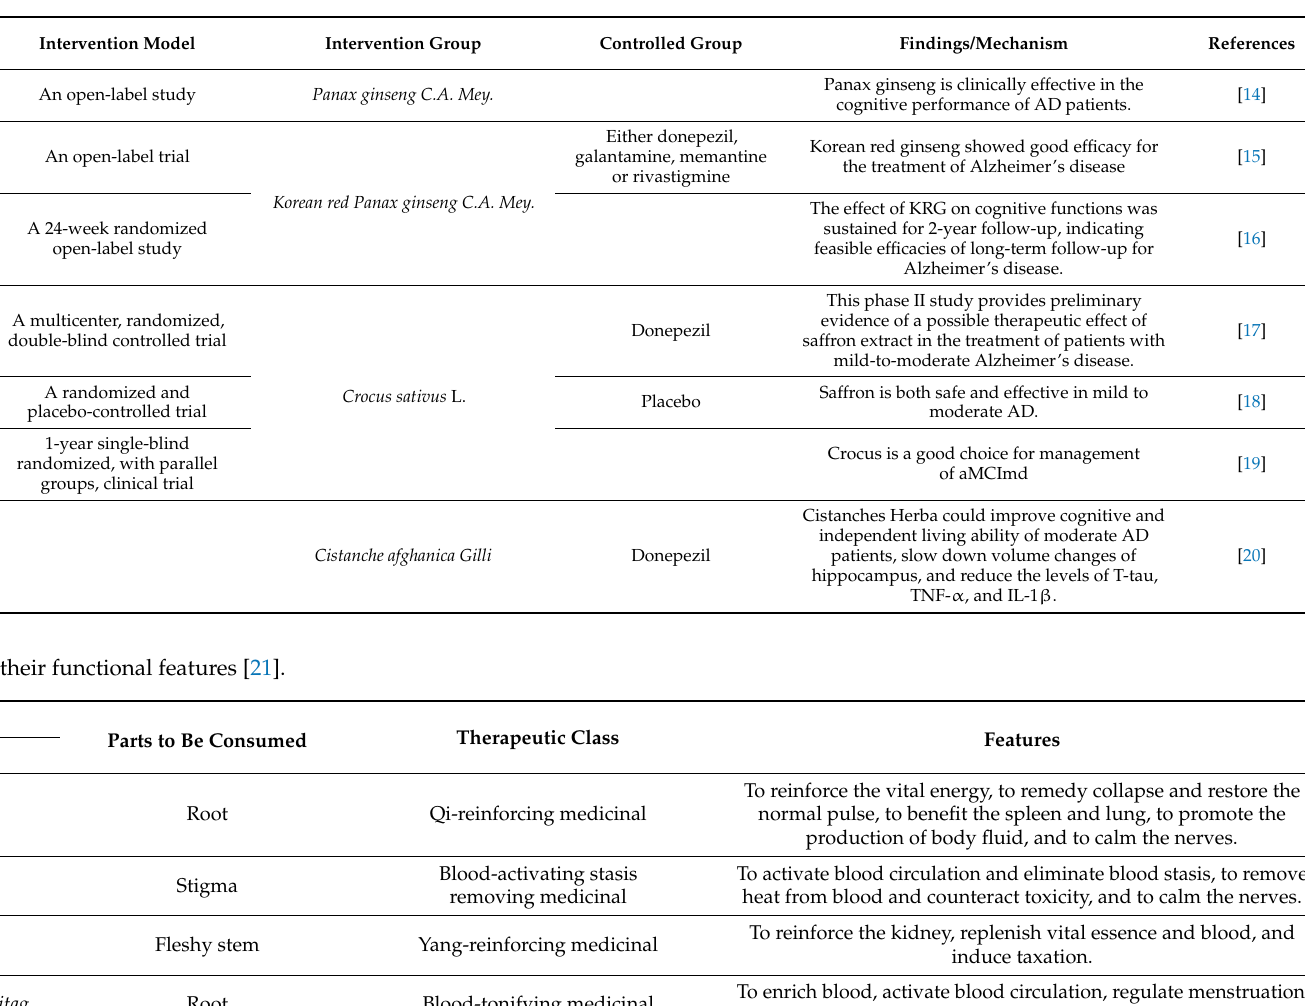
Table 1. The clinical evidence of prevention and treatment of Alzheimer’s disease using MFH.